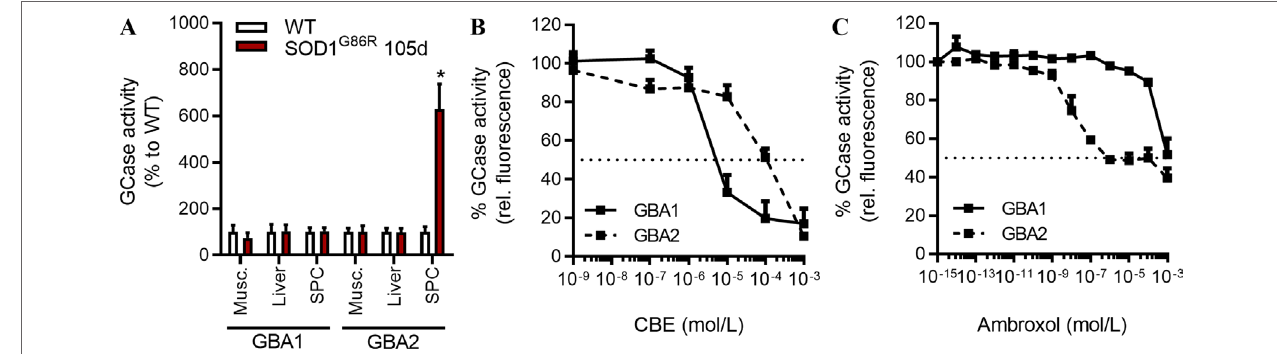
FIGURE 1 | GCase activities in symptomatic SOD1 G86R mice. (A) GCase activity in different tissues of SOD1 G86R and wild type (WT) mice at 105d ( n = 5–9/tissues, * p < 0.05). (B) GCase [glucocerebrosidase (GBA)] activity after conduritol B epoxide (CBE) dose-response ( n = 6/group). (C) GCase (GBA) activity after ambroxol hydrochloride (AMB) dose-response in liver tissue ( n =